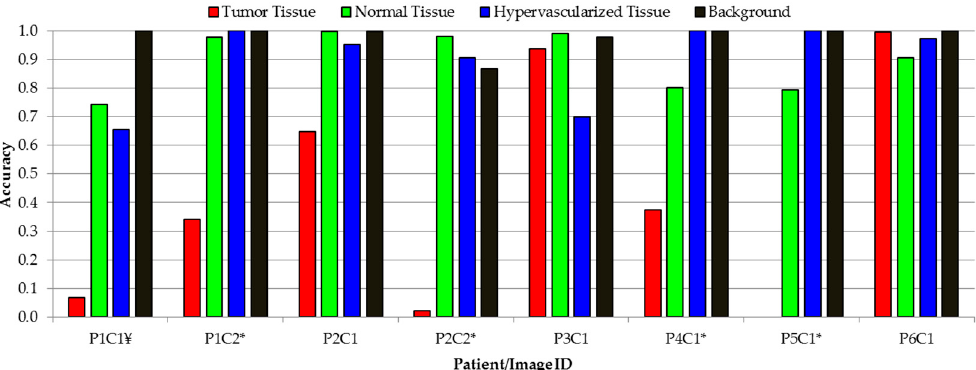
Figure 12. Class accuracy obtained with the proposed method for each test HS image. (*) Indicates the HS images acquired after beginning the resection. (¥) Indicates the image acquired with the tumor exposed in the surface, but under non-optimal illumination conditions.